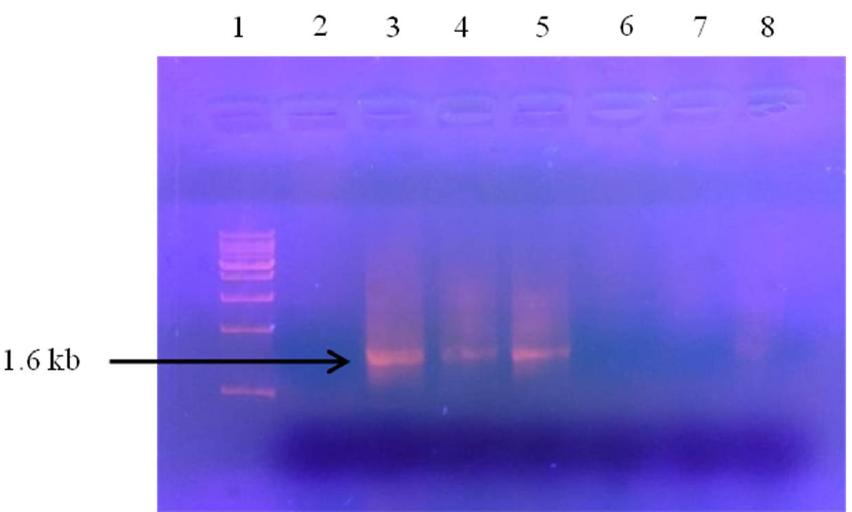
Figure 2. PCR detection of papaya leaf curl disease in papaya leaf samples: Lane 2 = healthy control leaf showing no symptoms. Lanes 3, 4, and 5 are symptomatic papaya leaf samples. The amplicon with band size of ≈1.6 kb in Lanes 3, 4 and 5 shows presence of PaLCuV. Lane 1 is a 250 base pair step up ladder (Genei, India). Lanes 6, 7, and 8 display leaf samples from asymptomatic field plants showing no amplification.